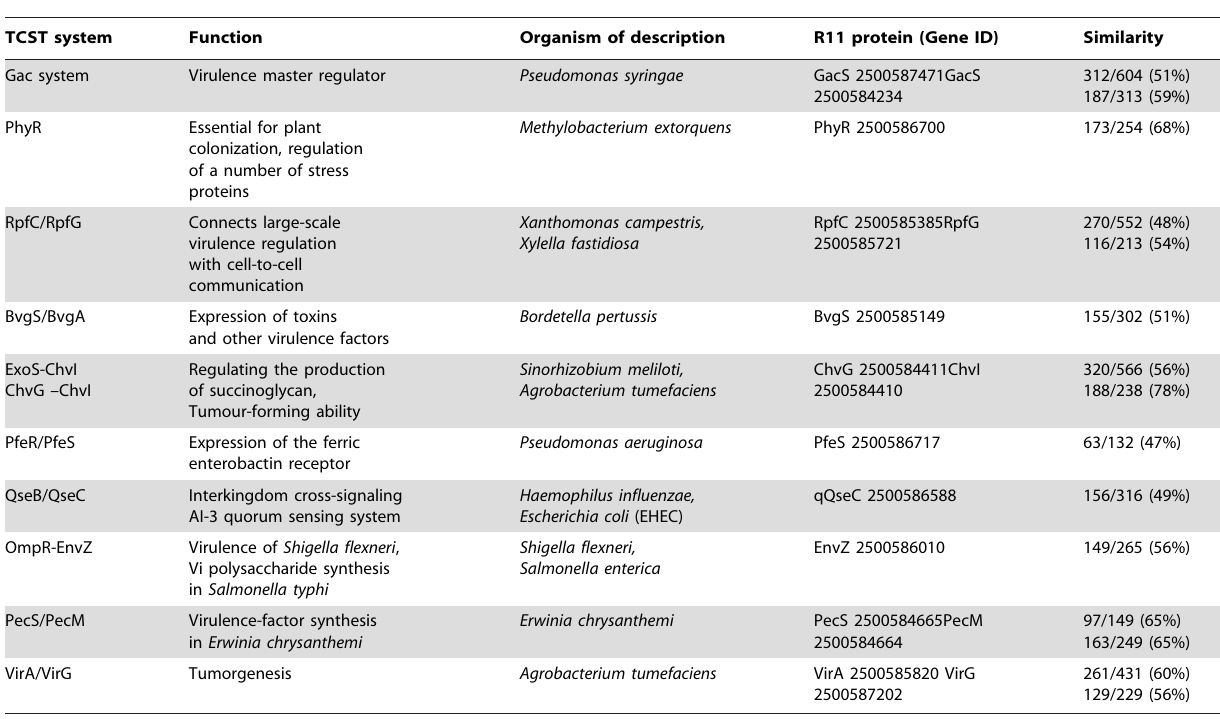
Table 4. Two-component signal transduction (TCST) systems in the R11 genome.